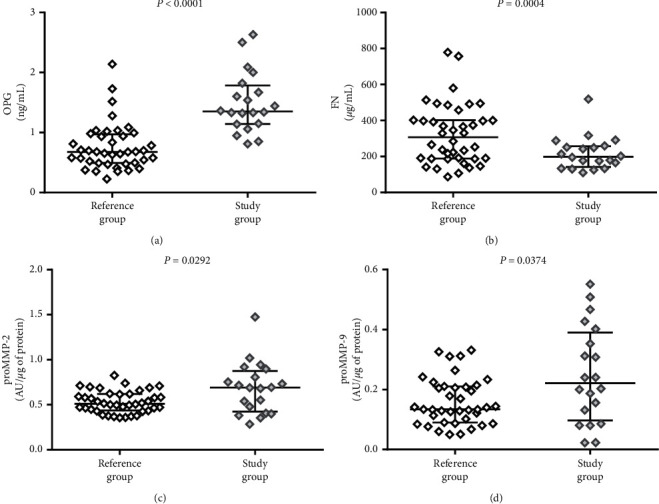
Comparison of (a) osteoprotegerin (OPG), (b) fibronectin (FN), (c) matrix metalloproteinase 2 proenzyme (proMMP-2), and (d) matrix metalloproteinase 9 proenzyme (proMMP-9) in plasma of patients (study group) and reference group. The middle lines represent the median, and the whiskers extend from the 25th to the 75th percentiles.